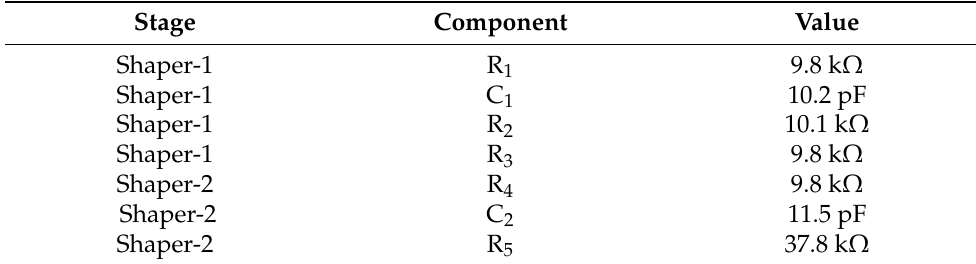
Table 1. Shaper Impedance network component